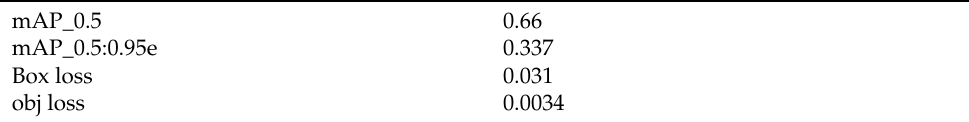
Table 8. Validation on SEAGULL—values of